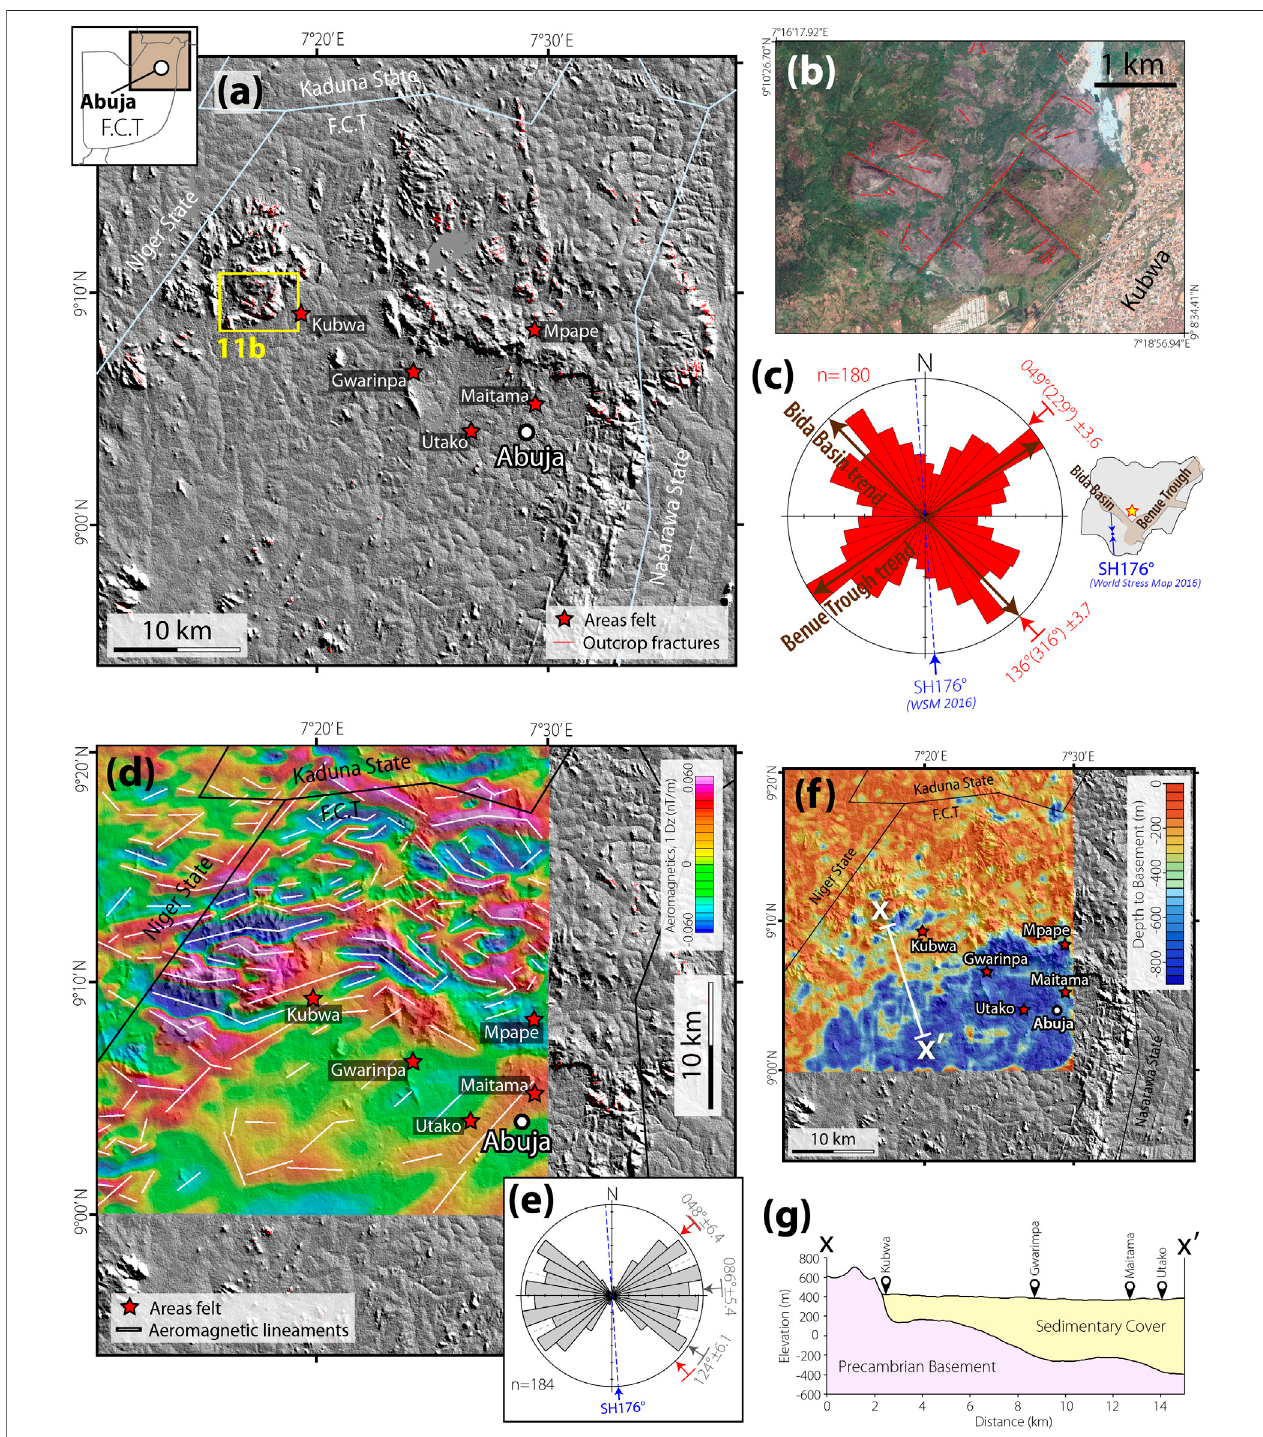
FIGURE 6 | (A) Satellitetopography hillshade map ofthe Abujaareaof theFederal CapitalTerritory (F.C.T.), Nigeria, showingareaswhere thetremor was felt (source: BBC Africa Hausa). (B) GoogleEarth © satelliteimageofapartoftheAbujaareashowinganexampleofsatellite-scalefracturesinthegraniticbasementoutcrops. (C) Rosediagramshowingtheazimuth- frequencydistributionofthesatellite-scaleoutcropfracturesintheentireAbujaareashownin Figure6A .SH (cid:1) maximumhorizontalcompressionalstressorientation(source:Heidbachetal., 2016).Inset:mapofNigeriashowingthelocationandorientationofSHdata(bluearrows),locationofAbuja(red-yellowstar),andMesozoicriftbasins(BT (cid:1) BenueTrough;BB (cid:1) Bida Basin). (D) Theverticalderivativeofthereducedtotheequator(RTE)aeromagneticmapoftheAbujaarea.Whitelinesrepresentthetrendsofbasementmagneticanomalylineaments.For “ SH, ” see6 (C) . (E) Rosediagramshowingtheazimuth-frequencydistributionoftheaeromagneticlineaments,whichrepresentthesubsurfacestructuralfabrics.ThemeantrendsoftheNW and NE dominant sets coincide considerably well with those of the satellite-scale outcrop fractures. (F) Depth to basement map, generated from the Source Parameter Imaging (SPI) transform of the aeromagnetic data, and the associated (G) cross-section, showing that the areas where the tremor was felt are located within a small sedimentary basin.